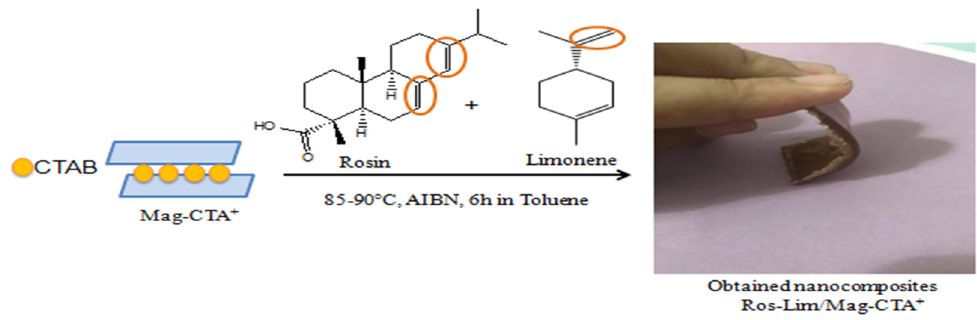
Table 1. Experimental conditions for the preparation of green-nanocomposites Ros-Lim / Mag-CTA + . Samples Ros Lim Mag-CTA + Time Yield Ros-Lim / Mag-CTA + 1% 9 g 5 g 1% (wt) 9